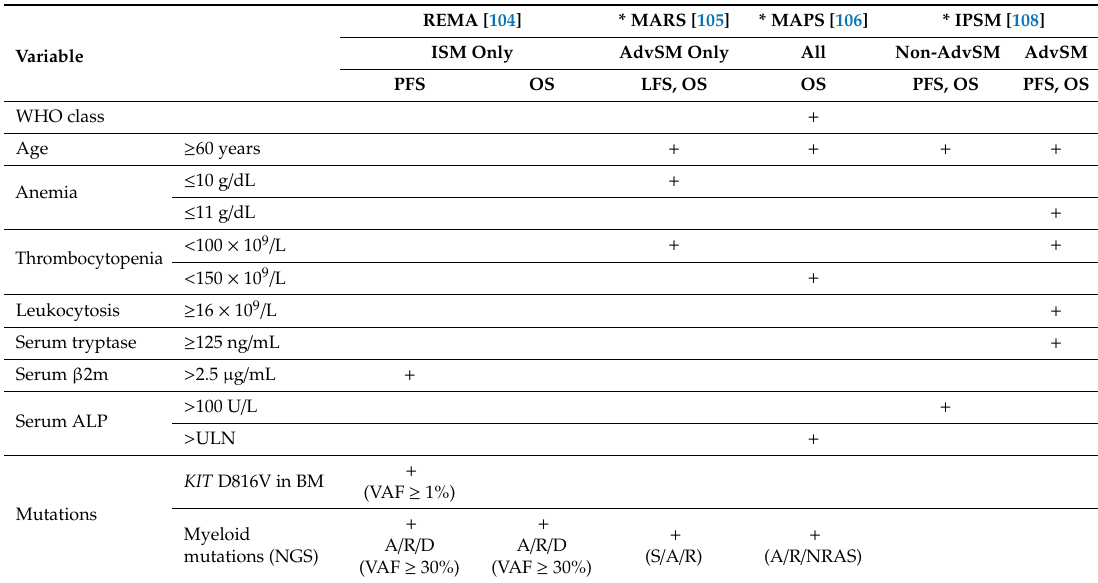
Table 2. Variables included in the di ff erent prognostic scoring systems recently proposed for risk stratification of SM